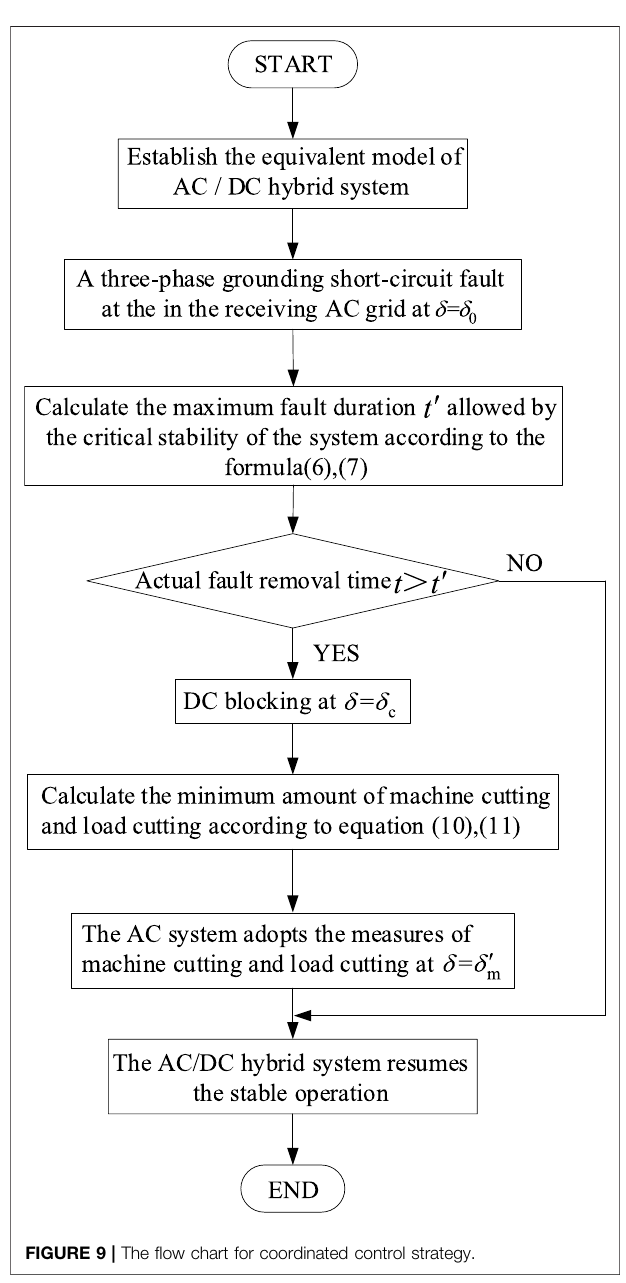
FIGURE 9 | The fl ow chart for coordinated control